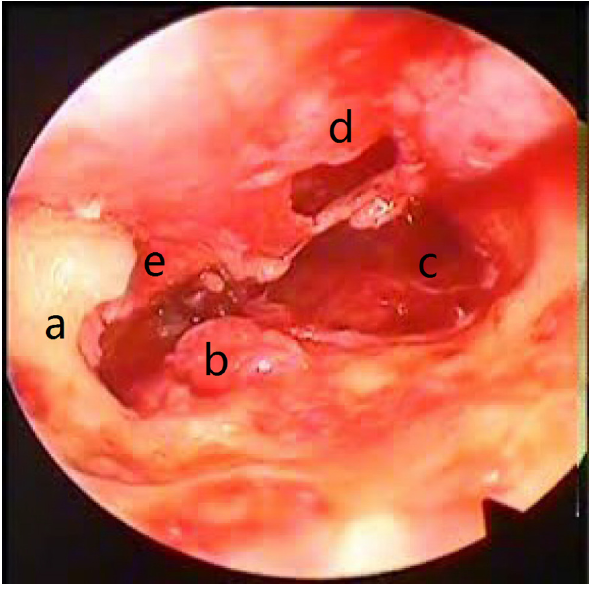
Fig 3. Preoperative middle ear microscopic view: (a) Scutum erosion; (b) Cholesteatoma and granulation tissue (around the stapes and facial recess); (d) Hypotympanum; (e) Tympanic membrane perforation; (f) Malleus.